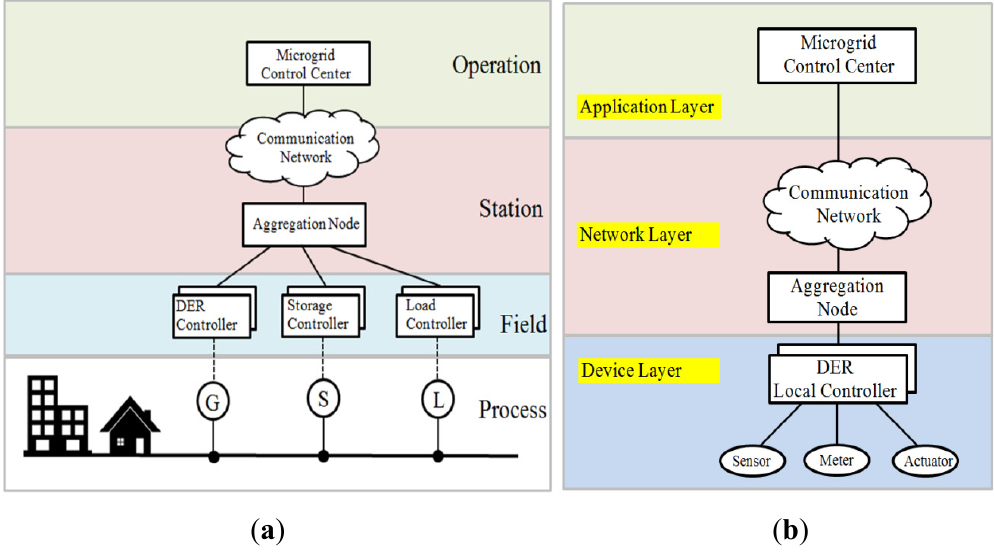
Figure 3. ( a ) Smart grid customer premises domain and hierarchical zones; ( b ) Microgrid three layers communication network